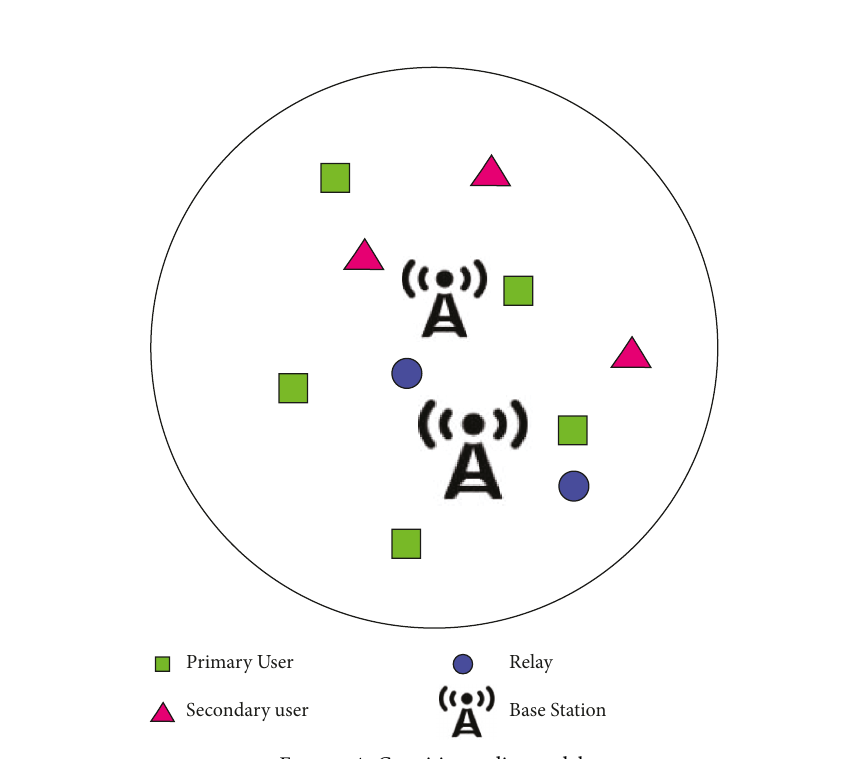
Figure 4: Cognitive radio model.